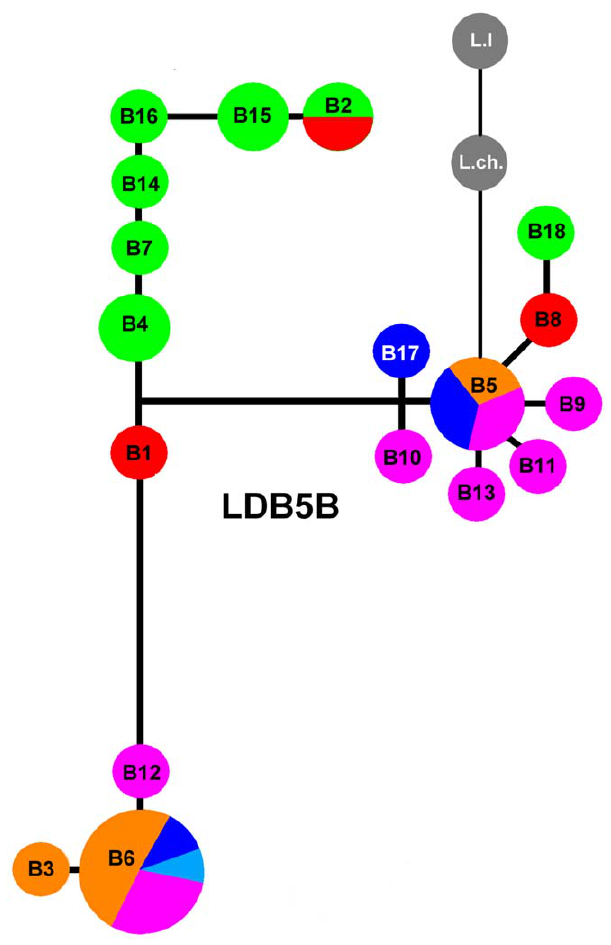
Figure 4. Haplotype networks for the nuclear gene LDB5B in L. pictus . Grey haplotypes correspond to the outgroups L. lemniscatus (L.l) and L. chiliensis (L.ch). Color codes as in the map of Fig. 1.